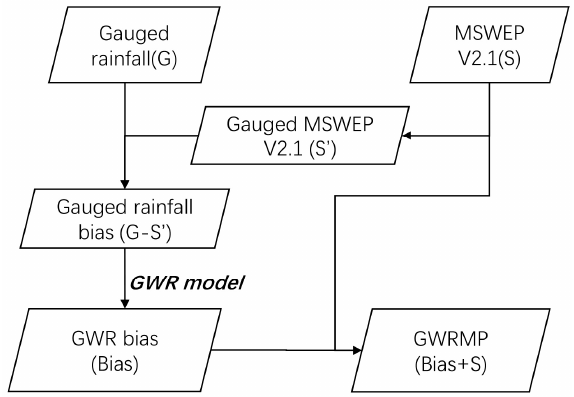
Figure 2. The general framework of GWR (geographically weighted regression) merging algorithms.